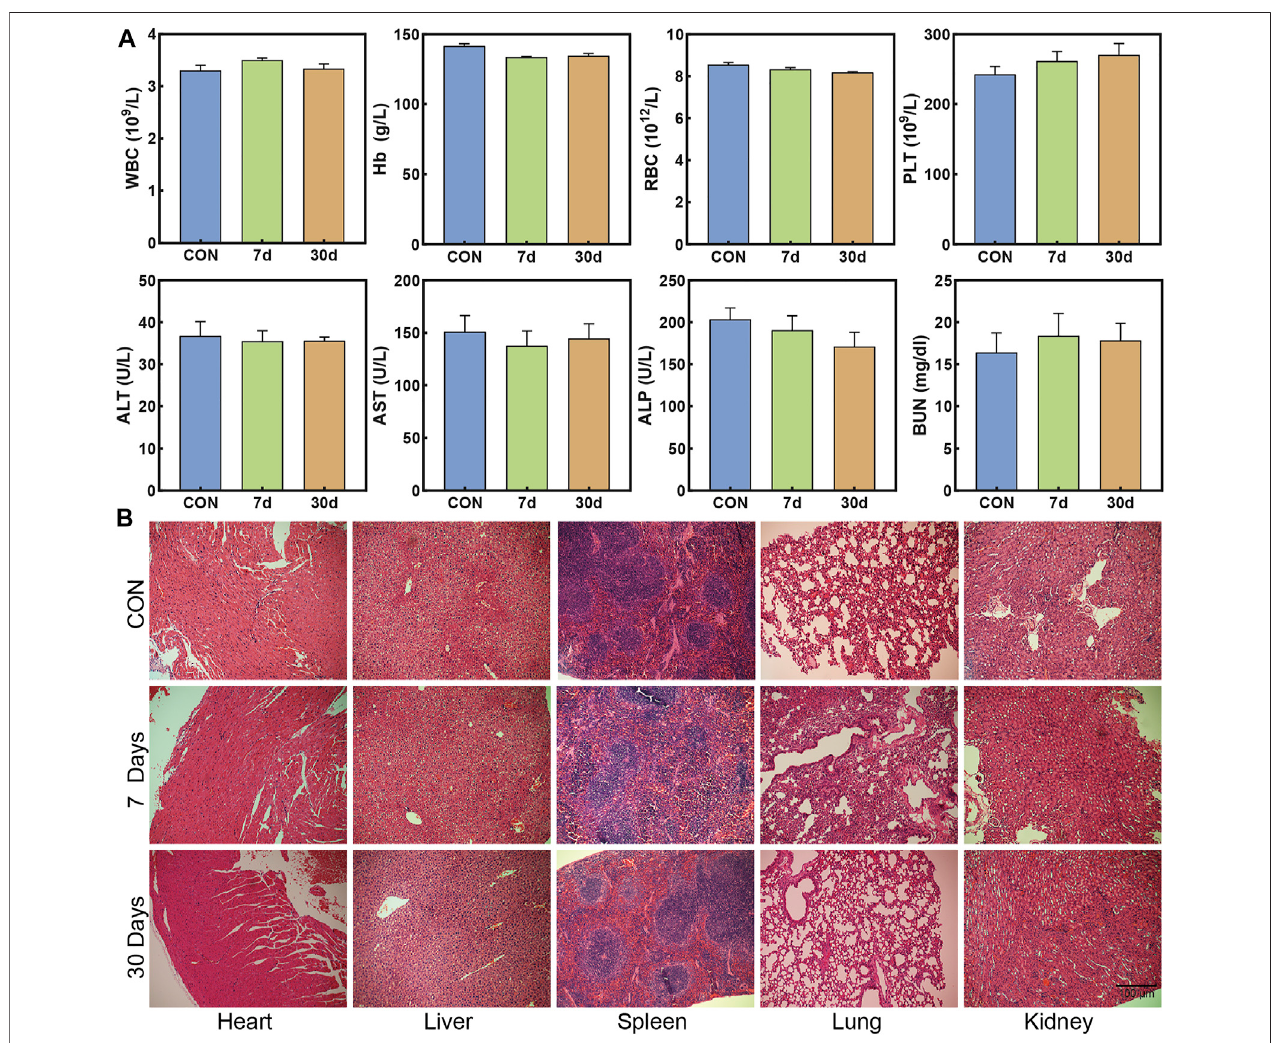
FIGURE7| Invivo biocompatibilityresearch.ThecountchangesofWBC,RBC,Hb,PLT,ALT,AST,ALP,andBUN (A) .H&Estainingofnudemiceafter7daysand 30 days of three injections of ZTC@M (B) (100×).